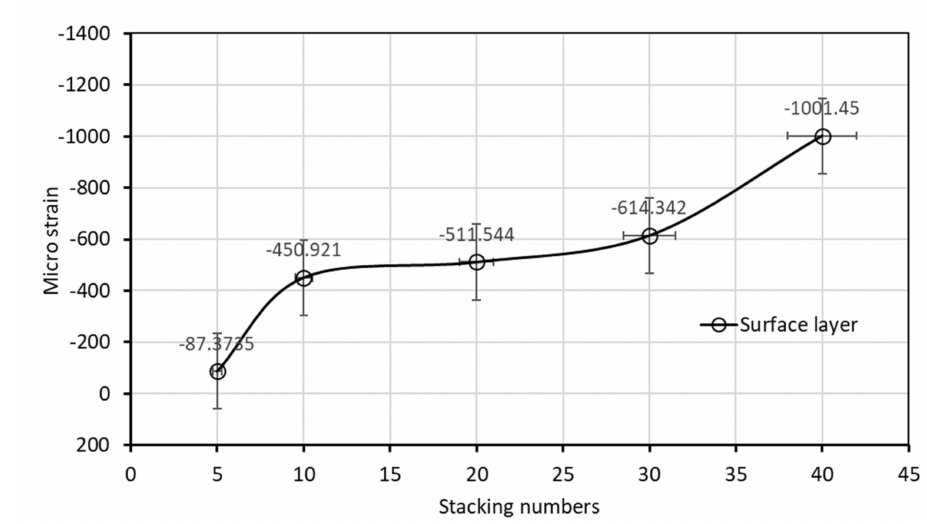
Figure 14. Residual strains of surface